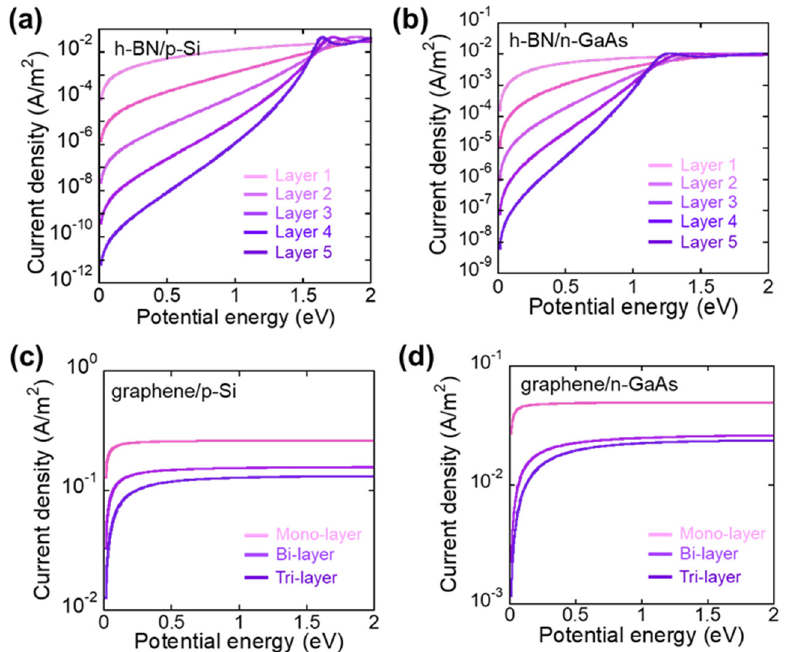
Figure 5. Calculated hole and electron current densities across ( a ) h-BN/p-Si, ( b ) h-BN/n-GaAs, ( c ) graphene/p-Si, and ( d ) graphene/n-GaAs with different thicknesses.